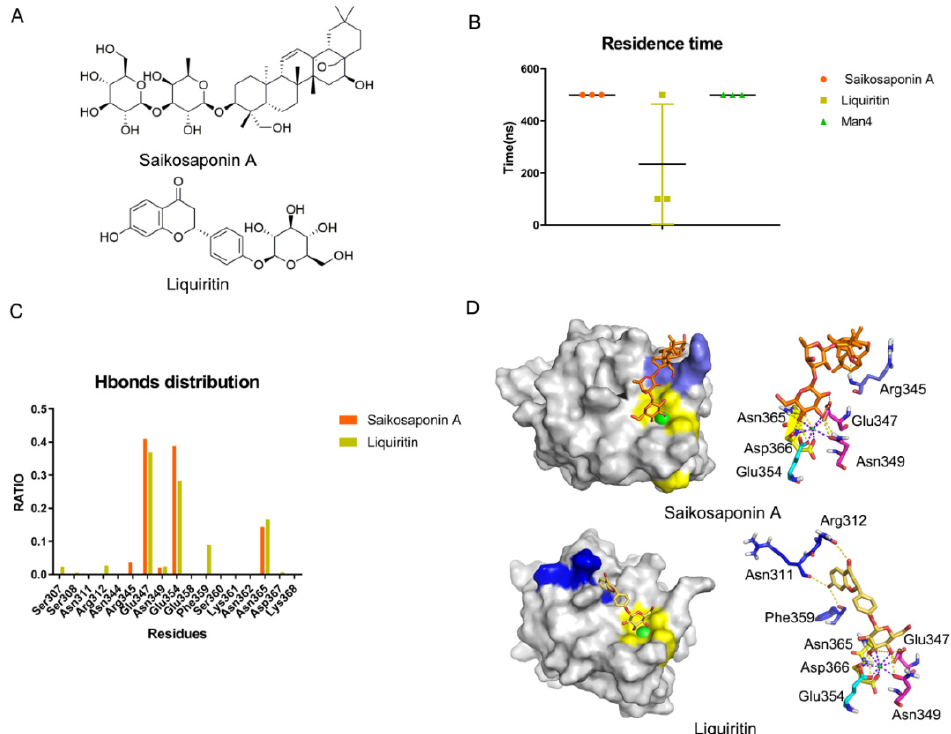
Figure 7. Saikosaponin A and Liquiritin bind to DC-SIGN in silico. ( A ) Structures of Saikosaponin A and Liquiritin . ( B ) Residence time of Saikosaponin A and Liquiritin and Man4 with DC-SIGN in three replicas. ( C ) Hydrogen bonds distribution RATIO about Saikosaponin A and Liquiritin . Glu347 and Glu354 mostly contributed. ( D ) Binding mode for Saikosaponin A and Liquiritin in DC-SIGN. Core site, consisted of Glu347, Asn349, Glu354, Asn365 and Asp366, is shown in yellow, Rift site is shown in blue; Valley is shown in purple-blue.